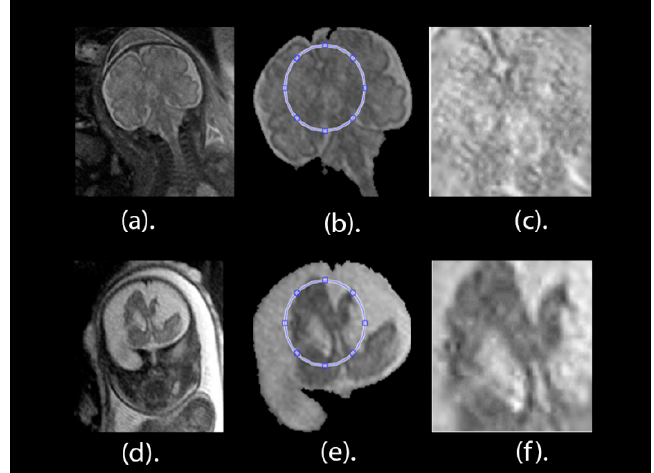
Figure 5. Brain pictures after contrast improvement and taking out the minor ROI. ( a ) is the full healthy brain picture afore segmenting the image. ( b ) The outlined ROI of the healthy fragmented brain. ( c ) The fragmented and improved ROI for a healthy brain. ( d ) The full unhealthy brain picture before segmenting the image. ( e ) The outlined ROI of the unhealthy fragmented brain. ( f ) The fragmented and improved ROI for an unhealthy brain.